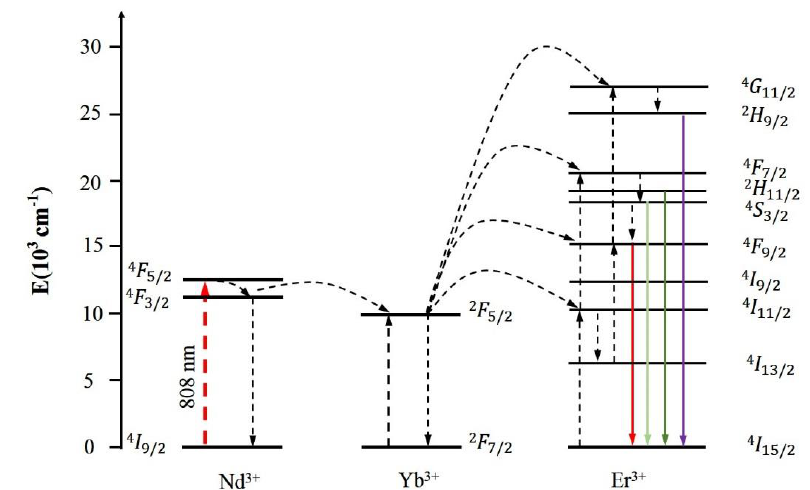
Figure 10. Proposed energy transfer mechanism of Nd 3+ , Yb 3+ , Er 3+ ions following diode laser excitation of 808 nm. The dashed-dotted, dashed, dotted, and full arrows represent the photon excitation, energy transfer, and emission